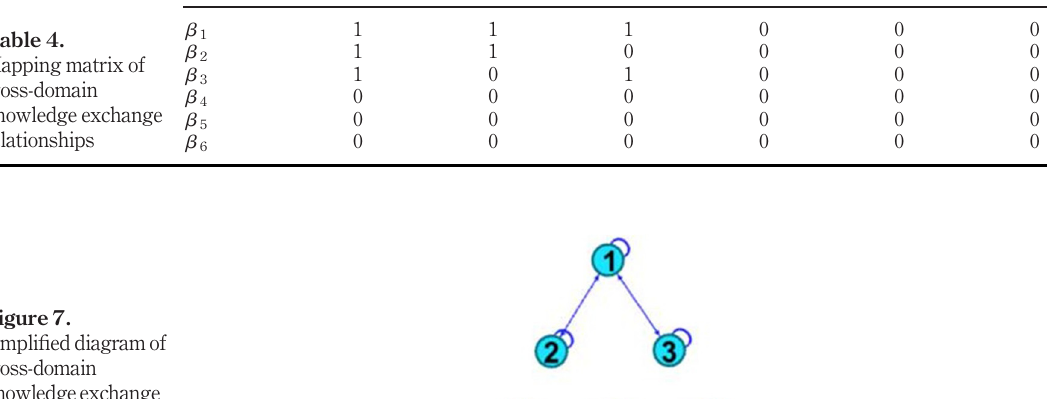
Figure 7. Simpli fi ed diagram of cross-domain knowledge exchange